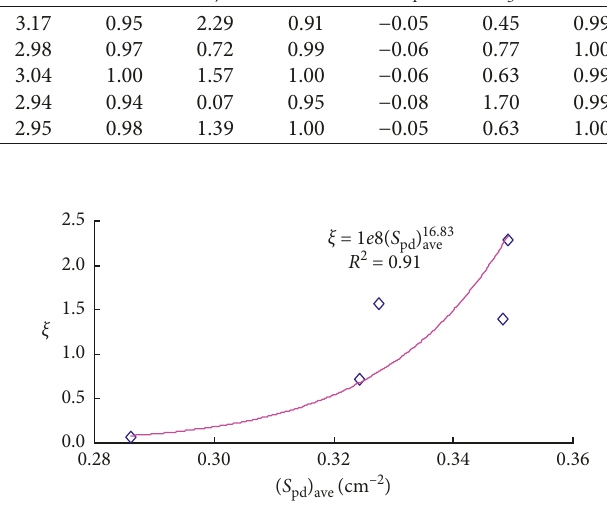
Figure 5: Relationship between ξ and ( S